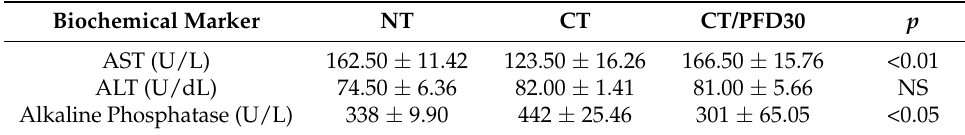
Table 1. Effect of PDF (30 days at 500 mg/kg) on serum markers of liver damage.